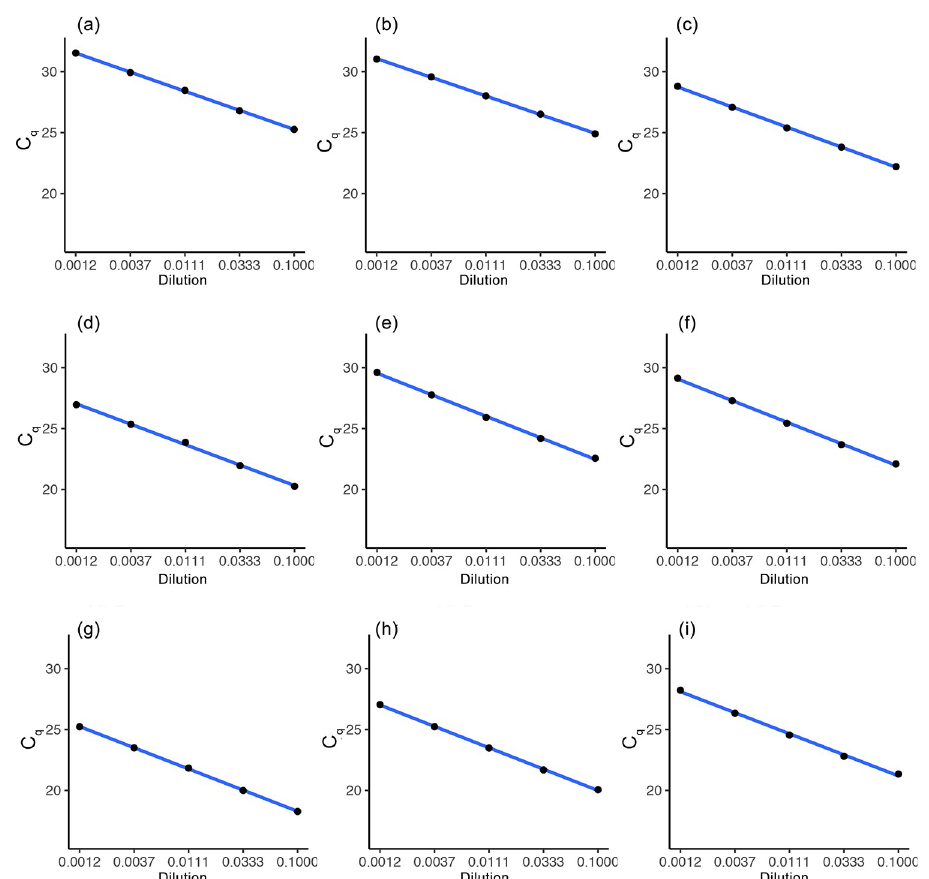
Fig 2. Primer efficiency for detection of Wolbachia strains and estimation of density. DNA was extracted in 250 μ L 5% Chelex 1 100 Resin and then diluted ten times before making a three-fold dilution series. The primer names are defined in Table